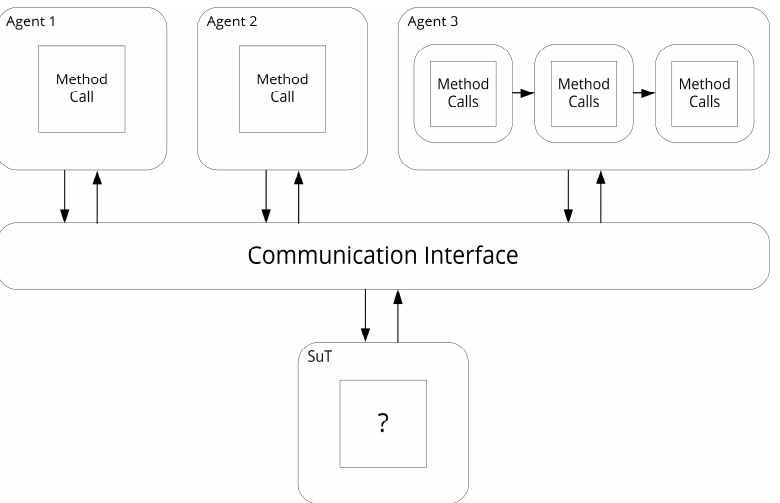
Figure 13. A possible manifestation of a specific simulation instance with differently abstracted agents (cf. Section 3.3) and the integration of the SuT at the system level (cf. Section